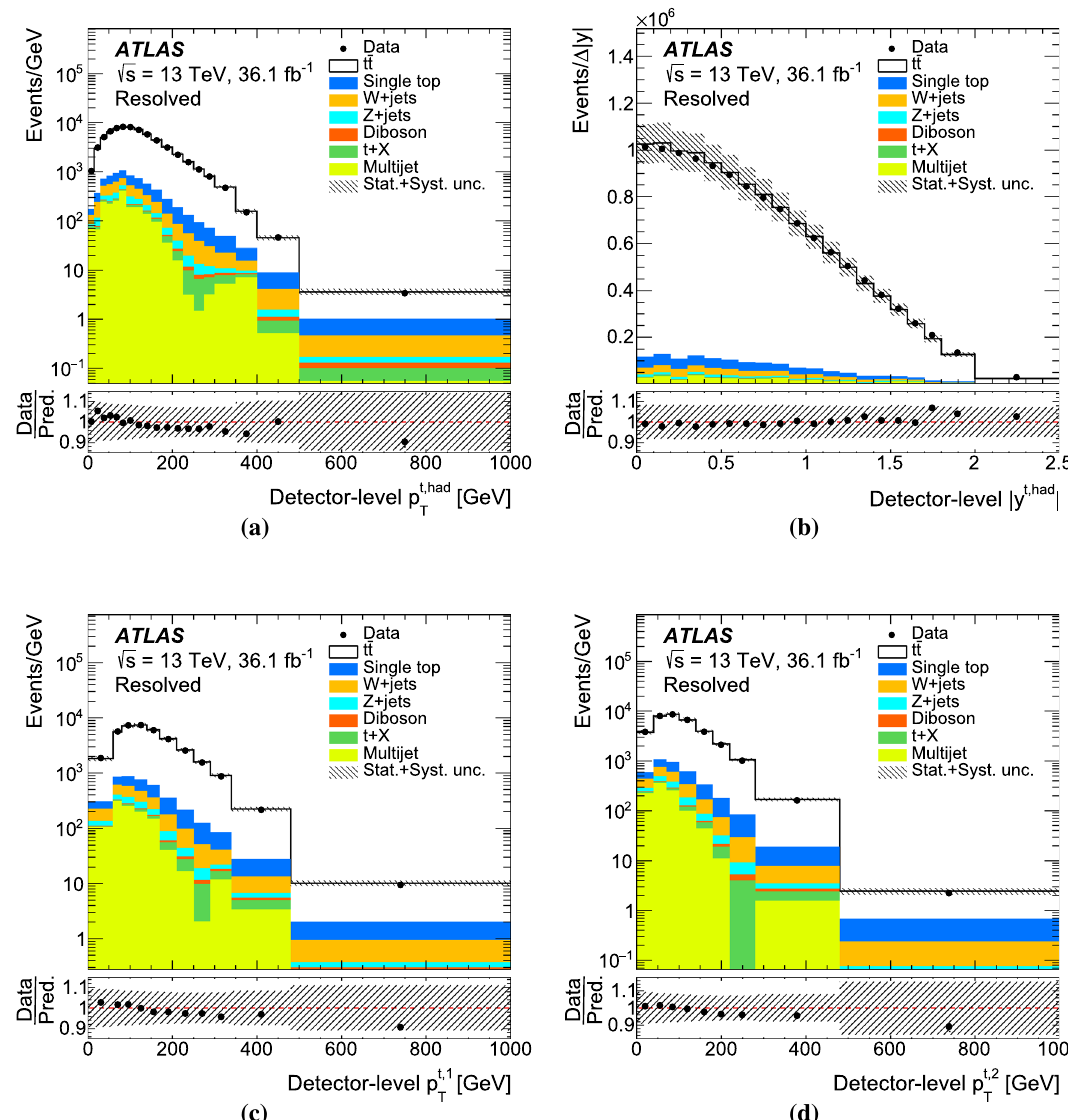
Fig. 6 Distributionsofobservablesinthe (cid:3) + jetschannelreconstructed withthepseudo-topalgorithmintheresolvedtopologyatdetector-level: a transverse momentum and b absolute value of the rapidity of the hadronic top quark, c transverse momentum of the leading top quark and d transverse momentum of the subleading top quark. Data distribu- tions are compared with predictions, using Powheg + Pythia8 as the t ¯ t